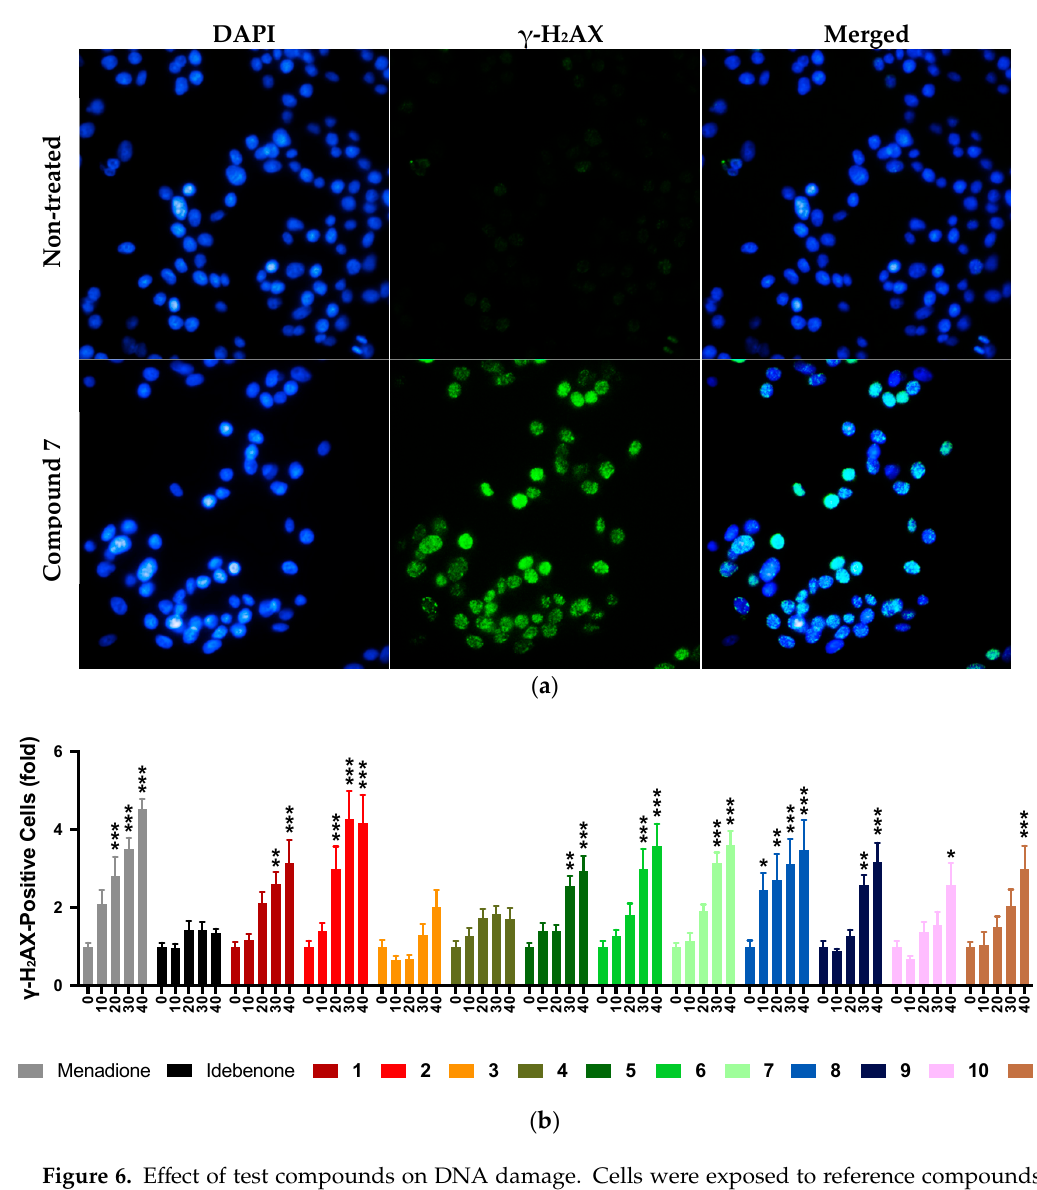
Figure 6. Effect of test compounds on DNA damage. Cells were exposed to reference compounds (menadione, idebenone) or test compounds (0–40 μ M) for 4 h before the presence of nuclear γ -H 2 AX positive cells was quantified. ( a ) Exemplary images (60 × magnification) used for quantitation of γ -H 2 AX-positive cells using compound 7 as positive treatment and ( b ) quantitation of results for all reference and test compounds. Data represent the mean ± SEM of 3 independent experiments with 4 parallel wells per experiment. Overall, >1000 cells were analysed per treatment. Two-way ANOVA was performed to compare test concentrations against the non-treated control: *** p < 0.001, ** p < 0.002, * p < 0.033.